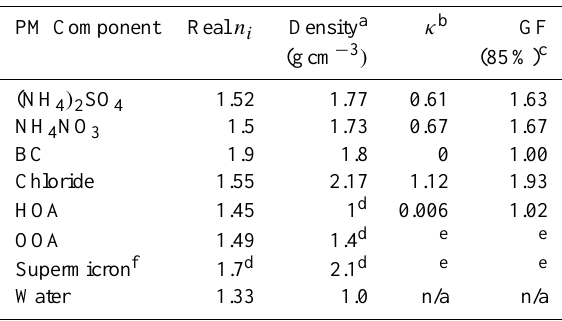
Table 1. Species properties used in model